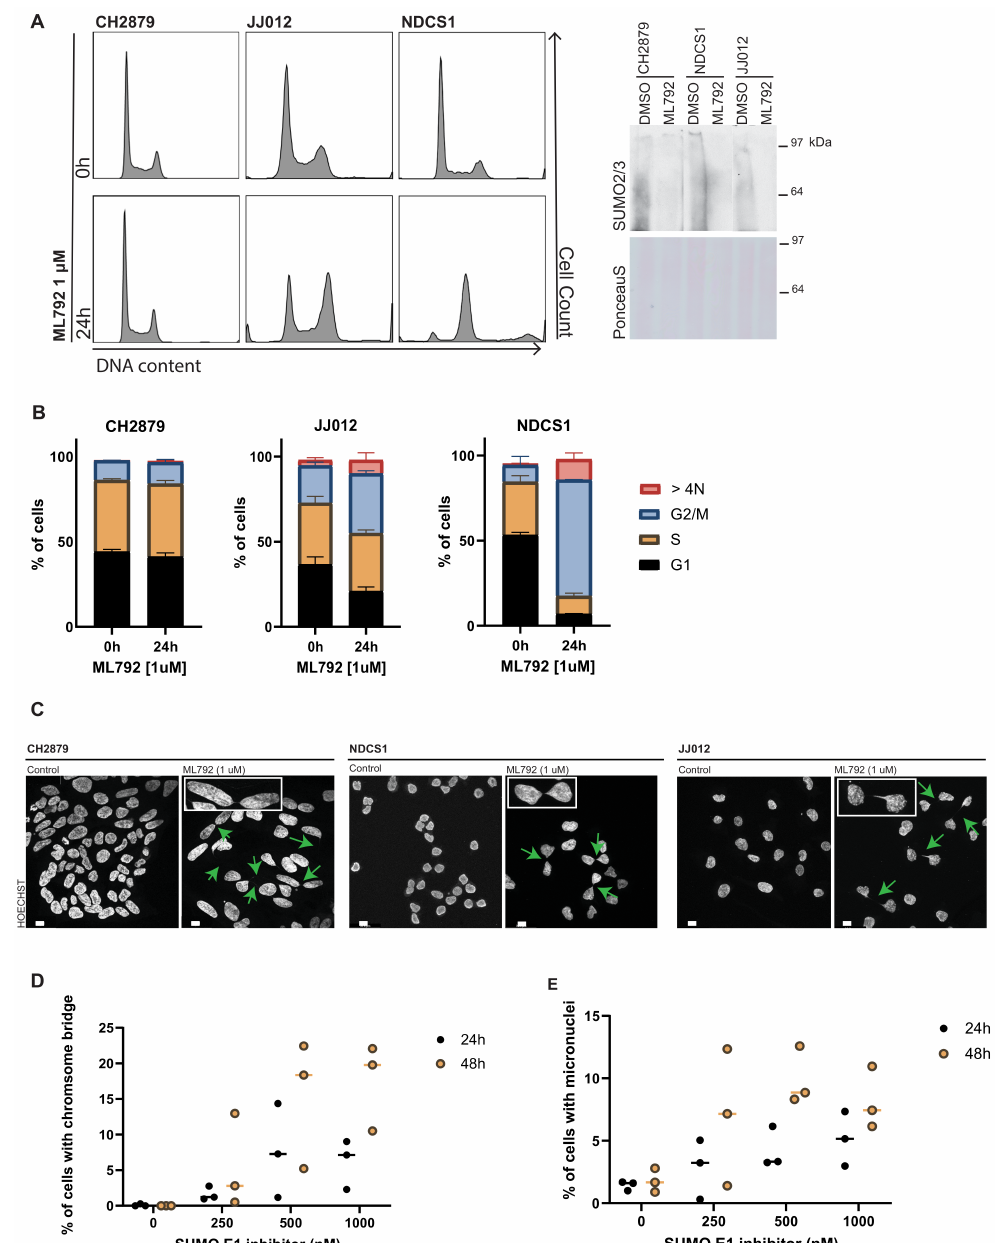
Figure 4. SUMO E1 inhibition leads to G2/M arrest and chromosome bridge formation. ( A ) Cell cycle analysis by flow cytometry of chondrosarcoma cell lines treated with ML792 for 24 h. Western blot analysis confirmed the inhibition of SUMO conjugation by the SUMO E1 inhibitor ML792. ( B ) Data representation of A in bar-graphs indicating G1, S, and G2/M pool of the cell lines for 0 or 24 hours of treatment as mean with standard deviation ( n = 3). ( C ) Immunofluorescence images of a-synchronous CH2879, NDCS1, and JJ012 cells treated with ML792 for 24 h. Cells were stained with Hoechst to visualize DNA. Green arrows indicate the location of chromosome bridges. Insert: magnification of a chromosome bridge. Scale bars represent 10 µ m. ( D ) Quantification of chromosome bridges in CH2879 cells upon treatment with the indicated concentration of the SUMO E1 inhibitor (ML792) for 24 and 48 h. For each replicate 15 images (approximately 200 cells total) per condition were analyzed. Data represent mean with standard deviation ( n = 3). ( E ) Quantification of micronuclei present in CH2879 cells upon treatment with the indicated concentration of the SUMO E1 inhibitor (ML792) for 24 and 48 h. For each replicate 15 images (approximately 200 cells total) per condition were analyzed. Data represents mean with standard deviation ( n =